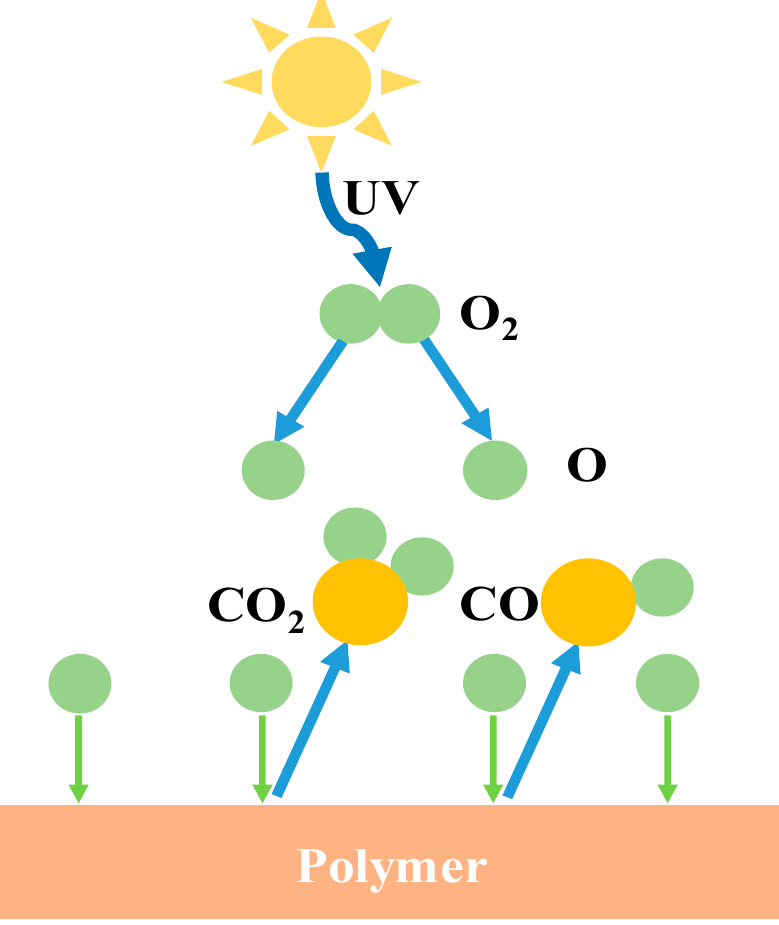
Figure 18. Diagram of atomic oxygen eroding the polymer. Lachance [170] and Russel [171] et al. prepared SiO 2 and Al 2 O 3 inorganic oxide coat- ings on PI surfaces by chemical vapor precipitation, and multilayer film stacks, such as Al 2 O 3 /TiO 2 and Al 2 O 3 /ZnO, prepared by atomic layer deposition (ALD) can also effec- tively avoid AO erosion, while ALD owns the disadvantage of high vacuum equipment requirement. Later, the liquid phase deposition method was developed, which generally formed the oxide film by the slow hydrolysis of the aqueous solution of a metal–fluorine complex ([TiF 6 ] 2 − ) in boric acid and water, achieving a robust interfacial adhesion. Gouz- man and Gotlib-Vainshtein et al. [172,173] successfully deposited TiO 2 and SnO 2 with a thickness of 100 nm onto a Kapton film by liquid phase deposition, respectively, and simulated an AO exposure environment durability test by an RF plasma of 99.999% pure oxygen gas (usually set an atom value of 10 20 cm − 2 order of magnitude as a standard for AO flux measurement in ground simulation facilities), and measured the weight